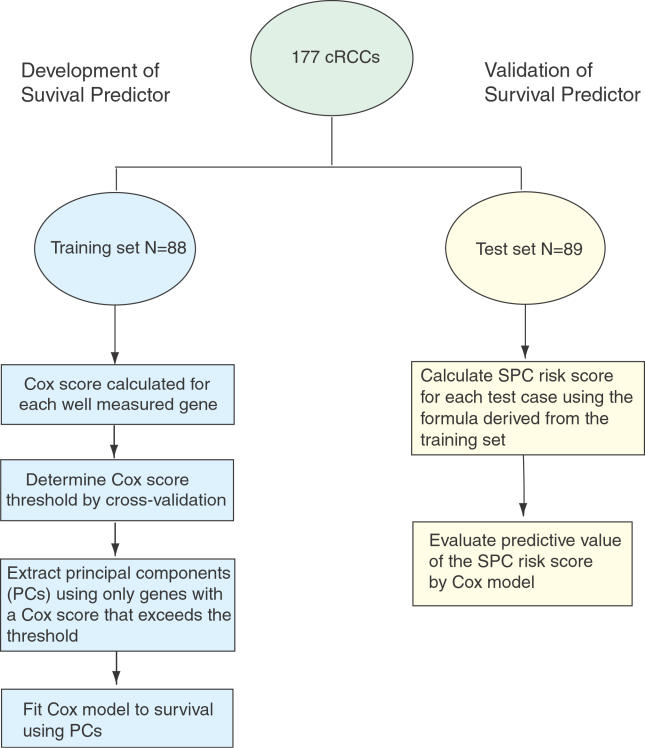
Overview of the Strategy Used for the Development and Validation of a Prognostic Gene List